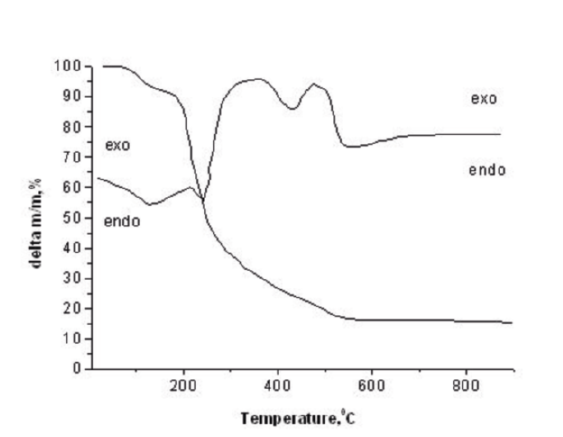
Figure 11. DTA-TG traces of the sample “Precursor”.